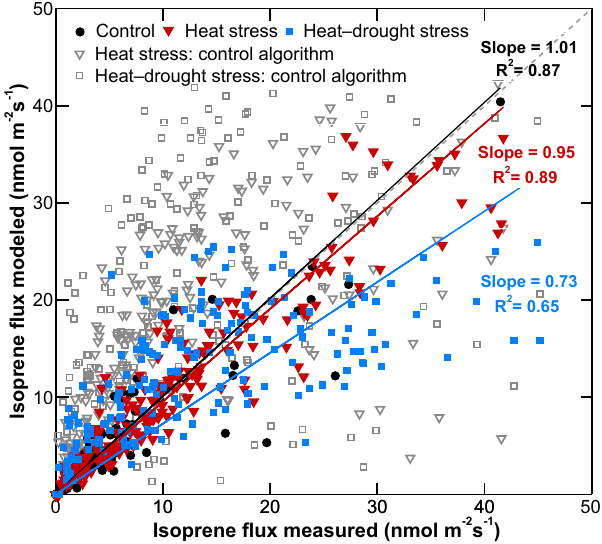
Figure 6. Modeled versus measured isoprene fluxes for trees ex- posed to control conditions (black circles), heat stress (red trian- gles) and heat–drought stress (blue squares) including a linear least square fit. Open grey symbols show isoprene fluxes modeled with the control algorithm instead of the corresponding algorithm for heat and heat–drought-stressed